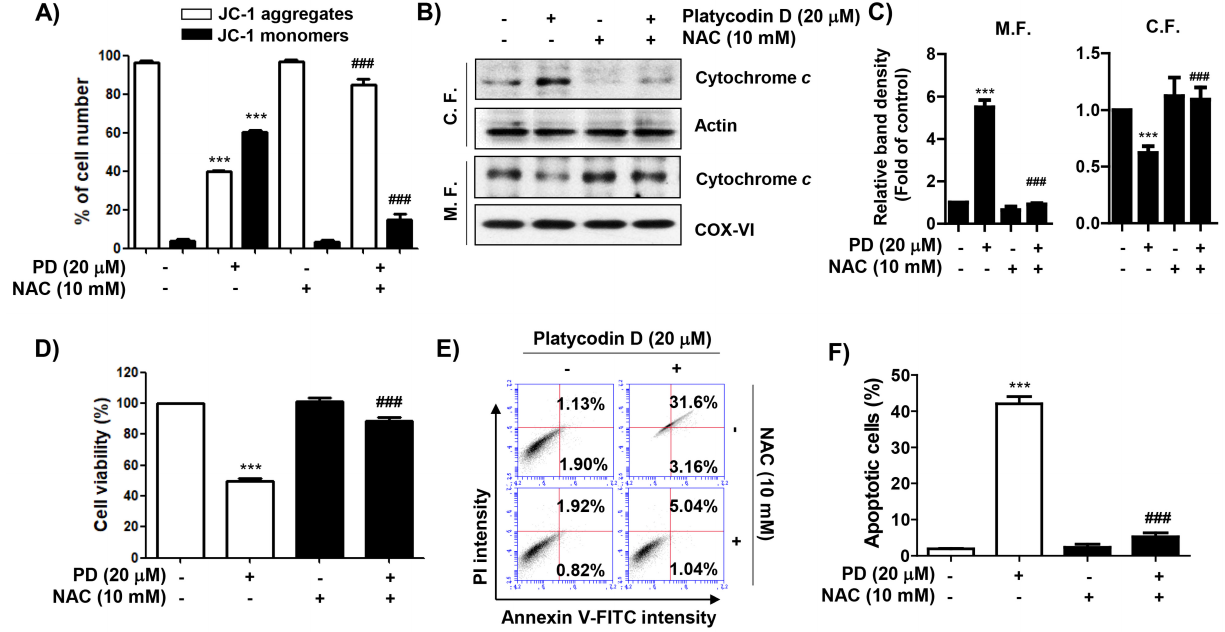
Fig. 5. The role of ROS on PD-induced cytotoxicity and apoptosis in PC3 cells. After pretreatment with 10 mM NAC for 1 h, and then 20 µ M platycodin was added to the medium for another 48 h. (A) The changes of MMP were determined by a flow cytometer. (B) Cytoplasmic and mitochondrial fractions were used to examine cytochrome c expression. (C) The expression of cytochrome c was indicated as fold change with control. Each bar indicated the mean ± SD of three independent experiments ( ∗∗∗ P < 0.001 compared to control; ### P < 0.001 compared to PD-treated cells). (D) Cell viability was measured the MTT assay. (E and F) The cells were fixed and stained with annexin V/PI for flow cytometry analysis. (E) Representative flow cytometry plots are presented. (F) The populations of apoptotic cells were determined by expressing the numbers of annexin V + cells. The data are presented as the mean ± SD of three independent experiments ( ∗∗∗ P < 0.001 compared to control; ### P < 0.001 compared to PD-treated cells; NS, not significant compared to PD-treated